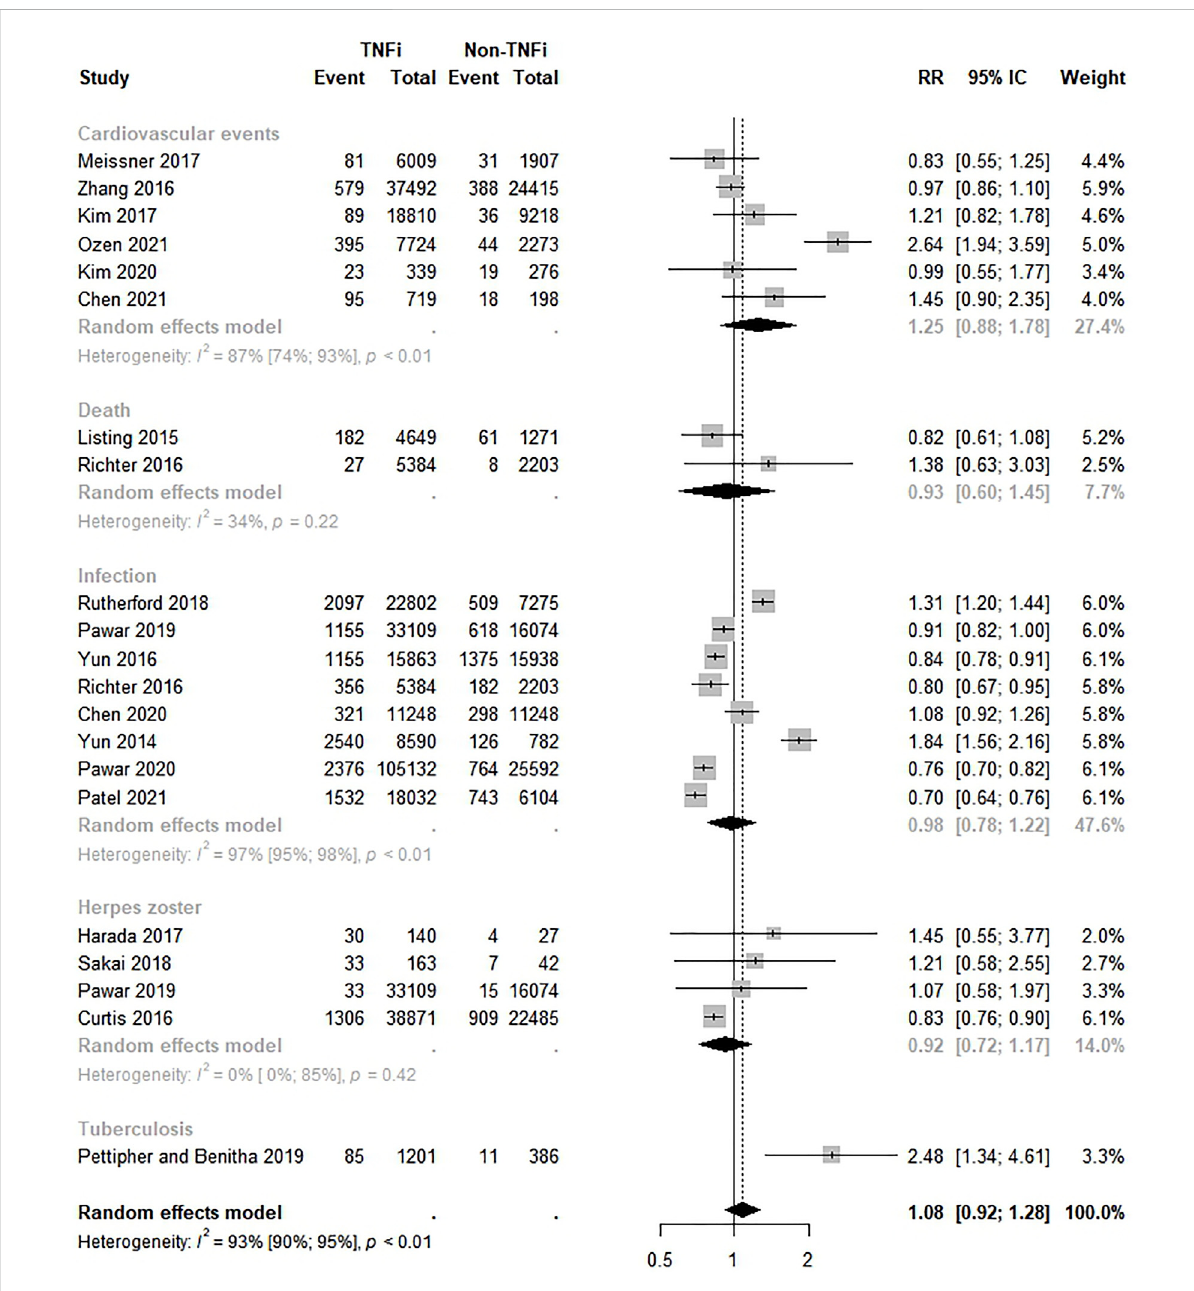
FIGURE 2 Comparative safety of TNF inhibitions and non-TNF inhibitions. TNFi: TNF inhibitions; non-TNFi: non-TNF